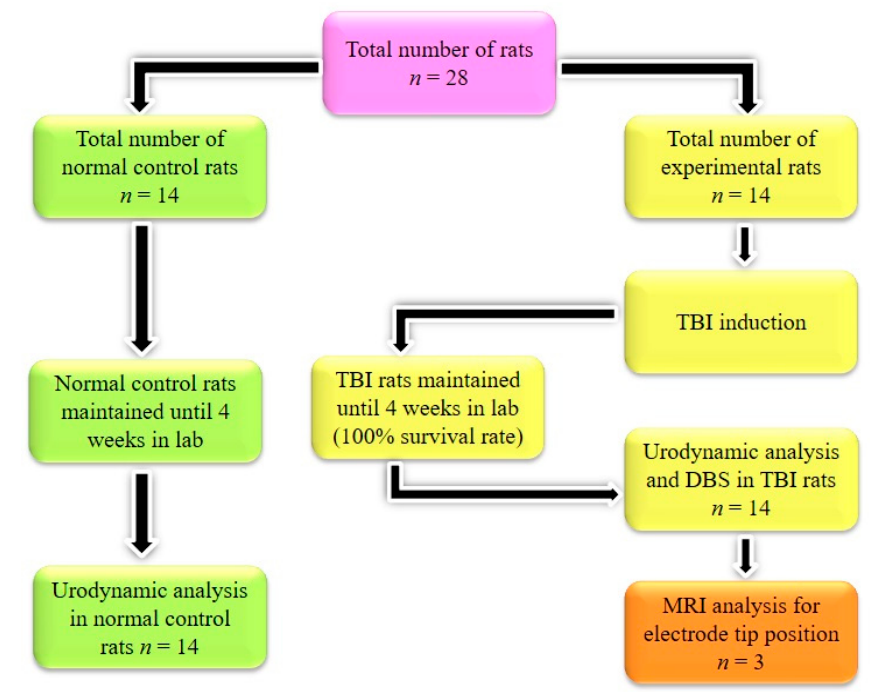
Figure 1. Schematic representation of the study design.